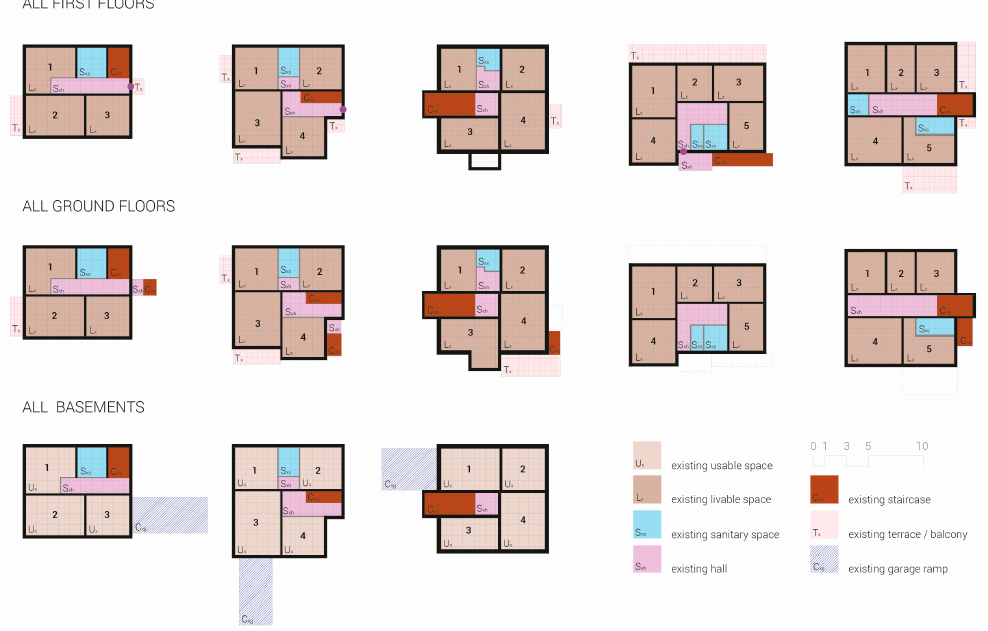
Figure 9. Existing floor plans with the classification of space functions (Ana Bel č i č , 2022).